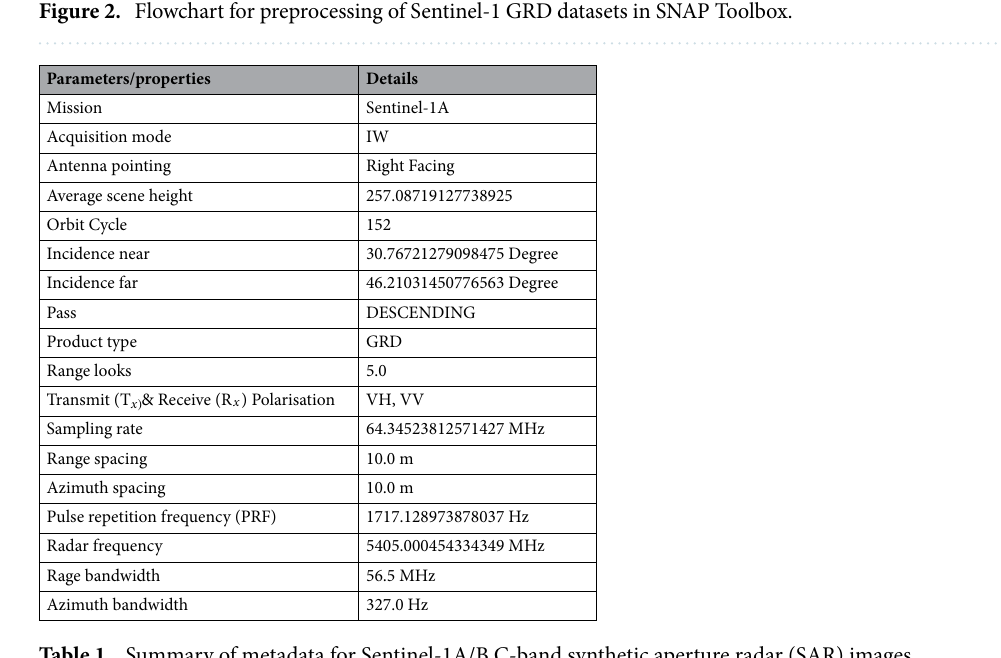
Table 1. Summary of metadata for Sentinel-1A/B C-band synthetic aperture radar (SAR)